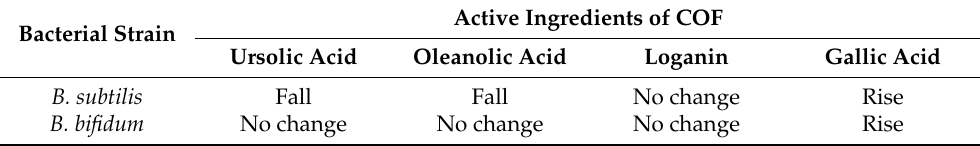
Table 1. Alteration of four active ingredients in COF after fermentation with B. subtilis and B. bifidum . Active Ingredients of COF Bacterial Strain Ursolic Acid Oleanolic Acid Loganin Gallic Acid B. subtilis Fall Fall No change Rise B. bifidum No change No change No change